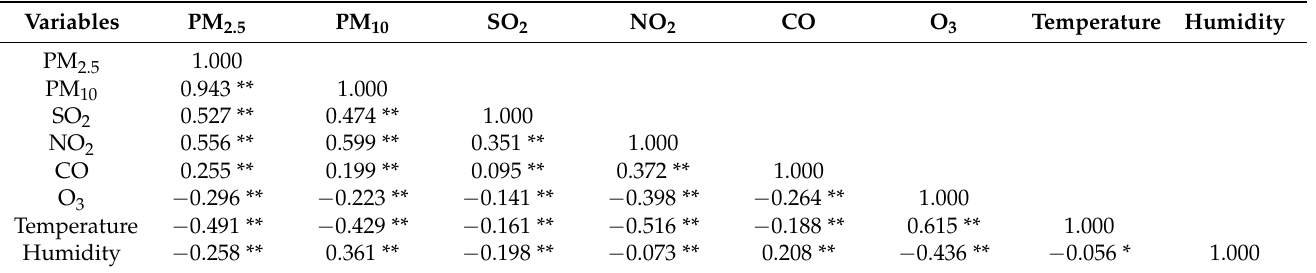
Table 2. Spearman correlation coefficients between daily air-pollutant concentrations and meteoro- logical factors in Enshi city,